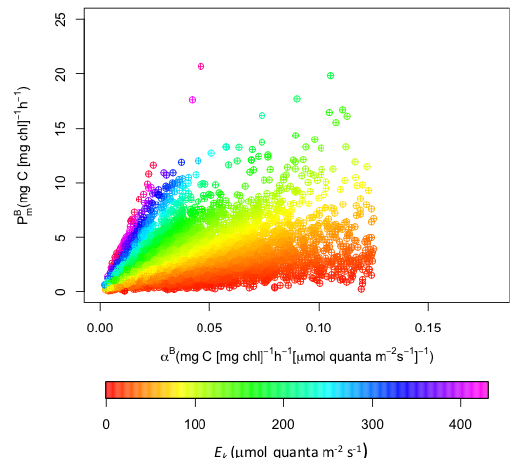
Figure 8. The assimilation number ( P B m ) plotted against the initial slope ( α B ). Symbol colours represent the value of E k in units of µmolquantam − 2 s − 1 .